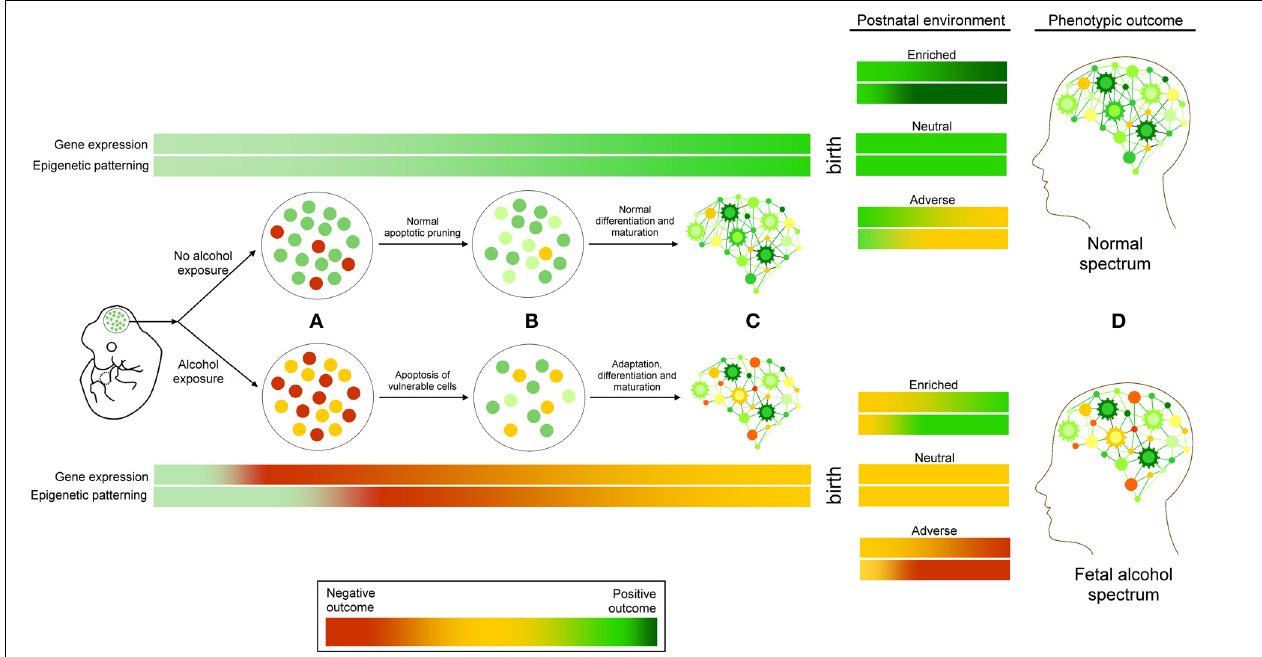
FIGURE 2 | A working model of FASD as a continuum of genetic and epigenetic events. (A) Ethanol exposure results in cellular stress response, leading to the apoptosis of vulnerable cell types. (B) These changes are followed by molecular adaptations in surviving cells that include changes to epigenetic programming, including DNA methylation, histone modifications,